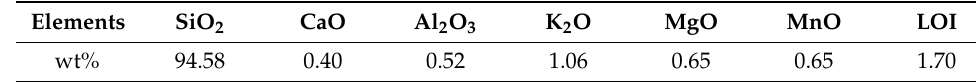
Table 2. Chemical composition of silica fume.